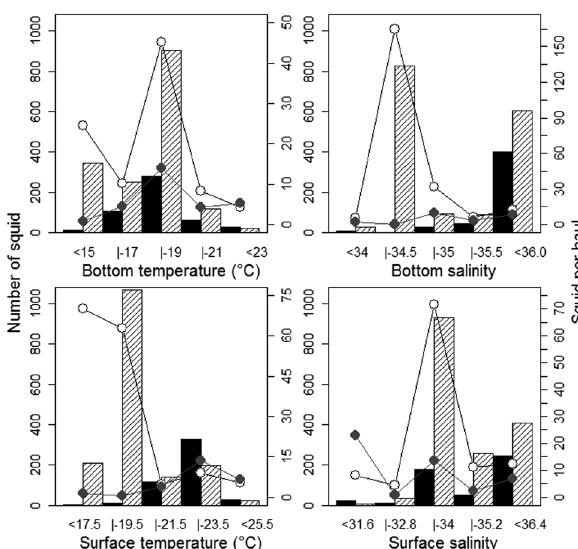
Figure 12. Total number and catch rates of Doryteuthis sanpaulensis and D. pleii collected in different temperatures and salinities during FAUNEC surveys off southern Brazil. Both metrics were calculated for stations where at least one of the two species was present. Bars: num- ber of squid. Circles: squid per haul. Crosshatched bars and empty circles: D. sanpaulensis . Black bars and dark grey circles: D. pleii .